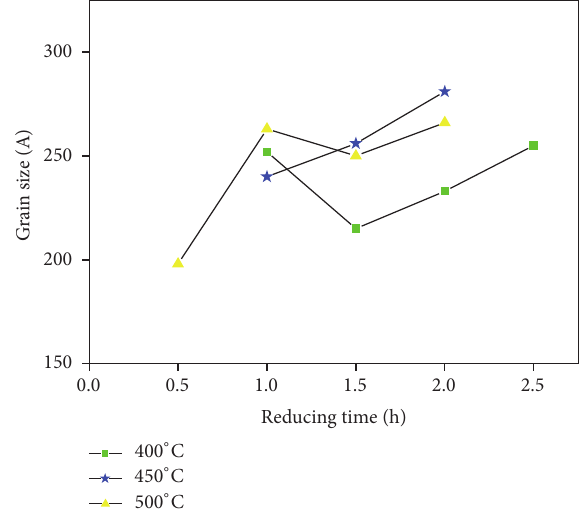
Figure 8: XRD patterns of samples reduced at 450 ∘ C.